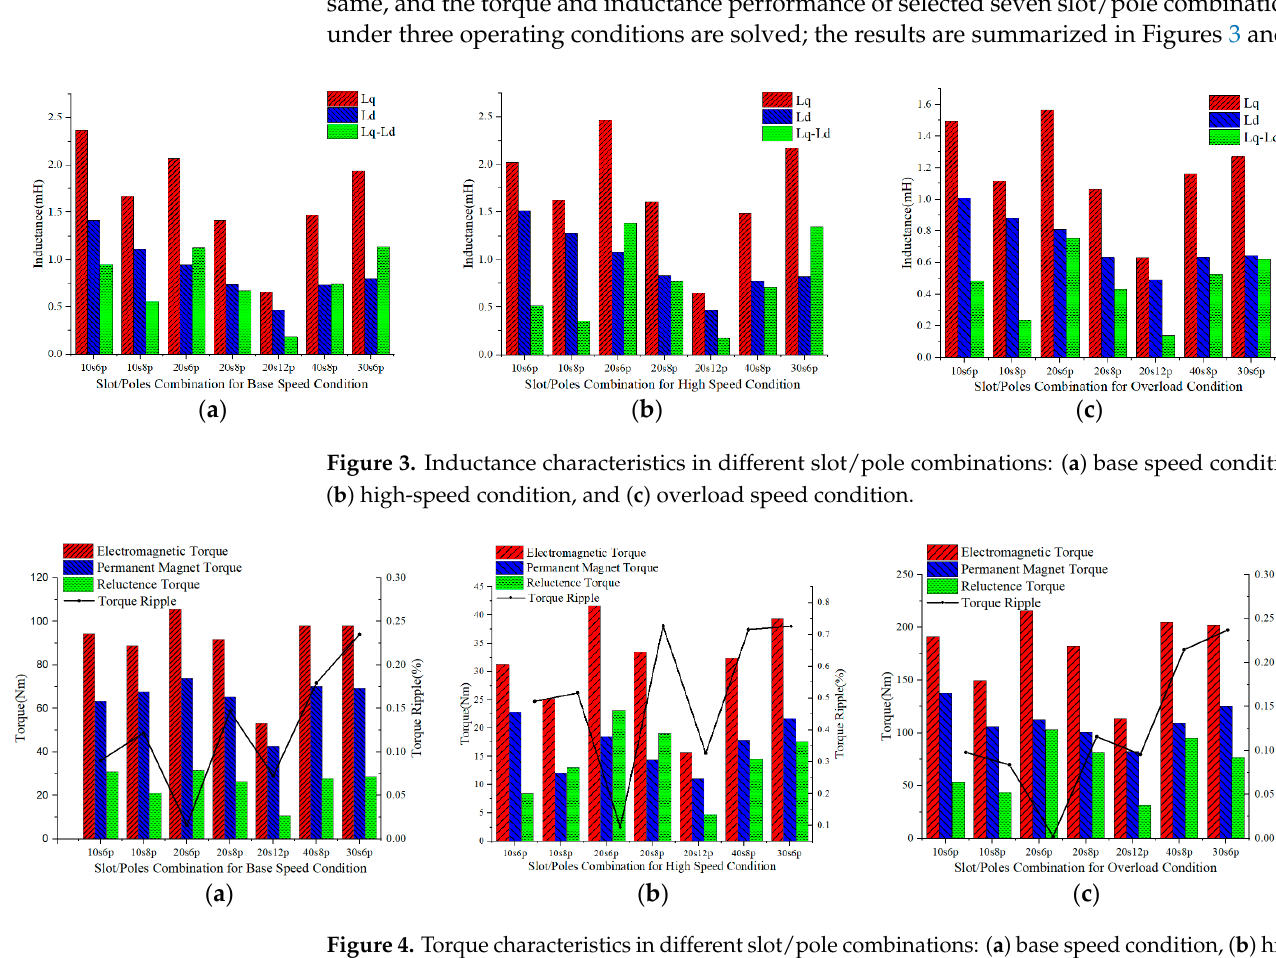
Figure 2. Selected Seven Different Slot/Pole Combinations: ( a ) 10s6p. ( b ) 10s8p. ( c ) 20s6p. ( d ) 20s8p. ( e ) 20s12p. ( f ) 30s6p. ( g ) 40s8p.